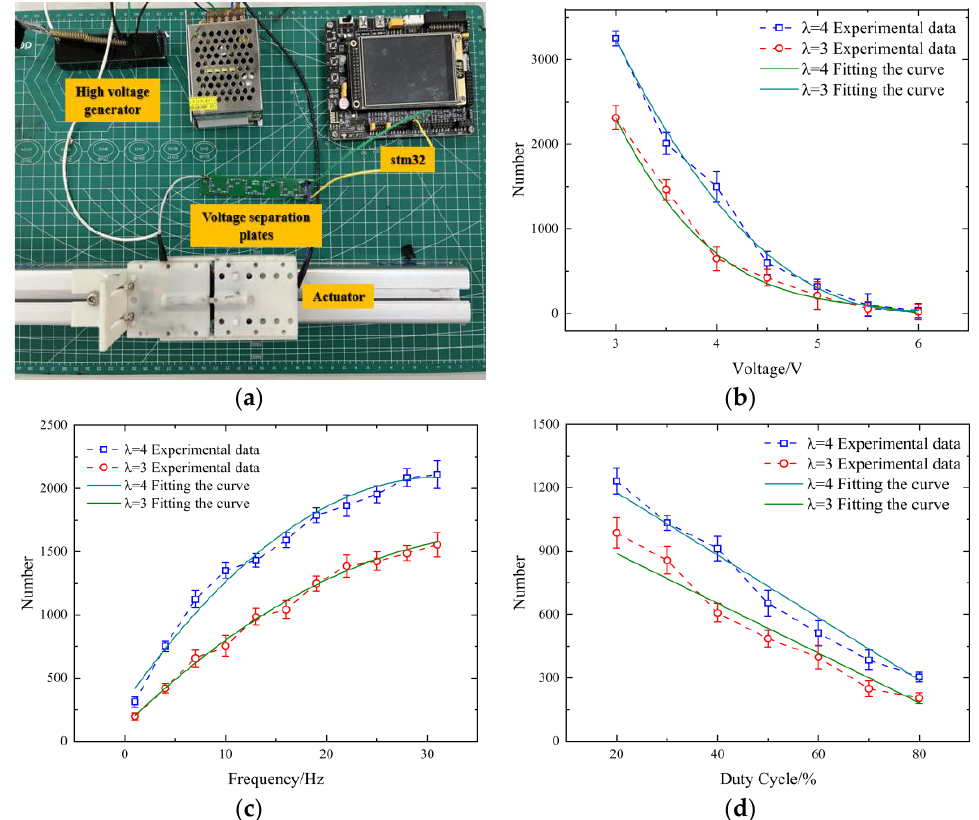
Figure 7. ( a ) The figure shows the fatigue count measuring device for the actuator. ( b ) Relationship between voltage and number of fatigue cycles. ( c ) Frequency in relation to number of fatigue